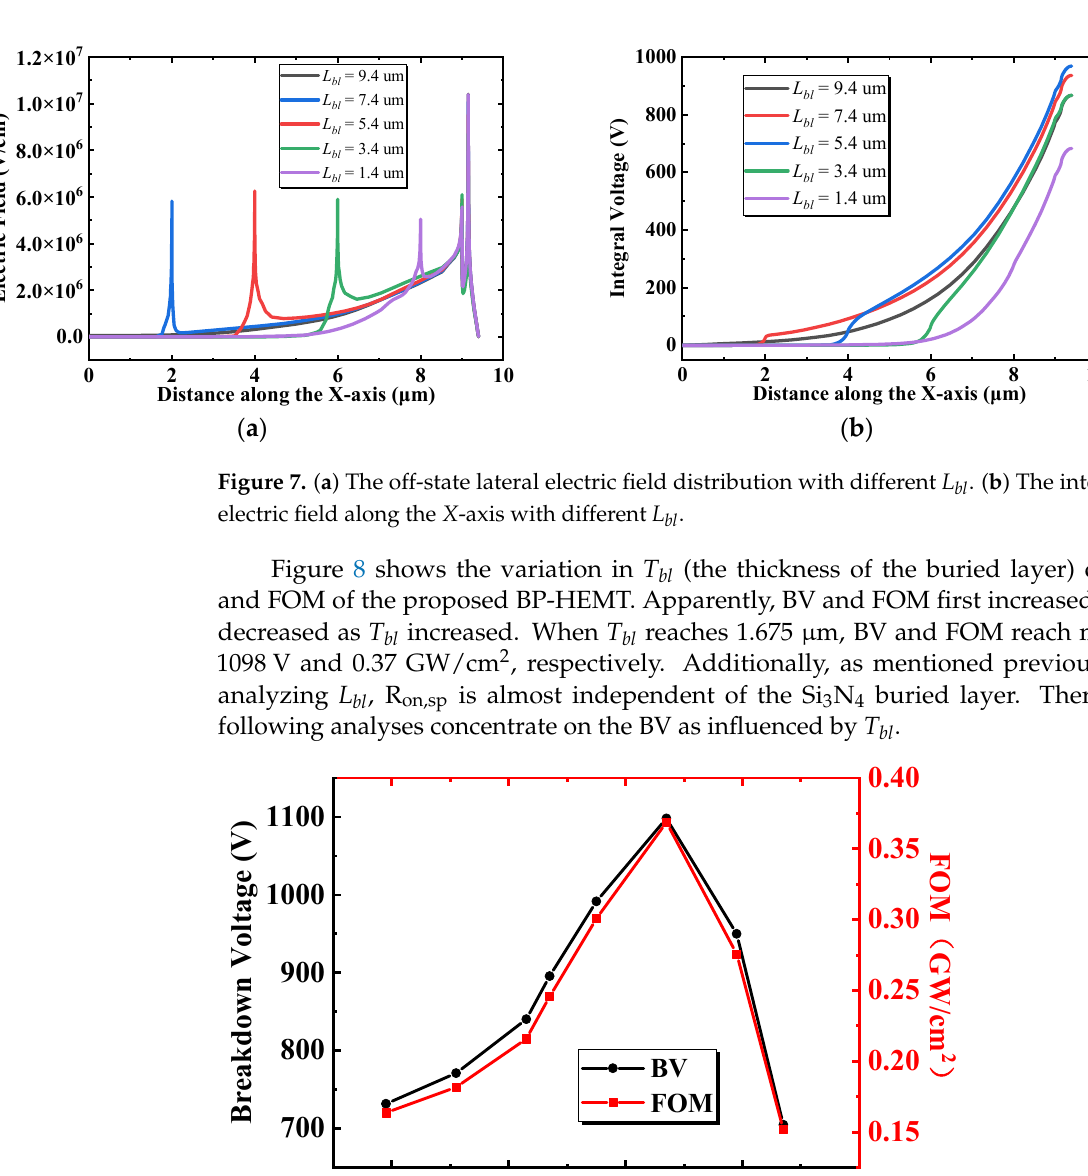
Figure 6. The influence of the length of the buried layer on the breakdown voltage and the FOM of the proposed BP HEMT.